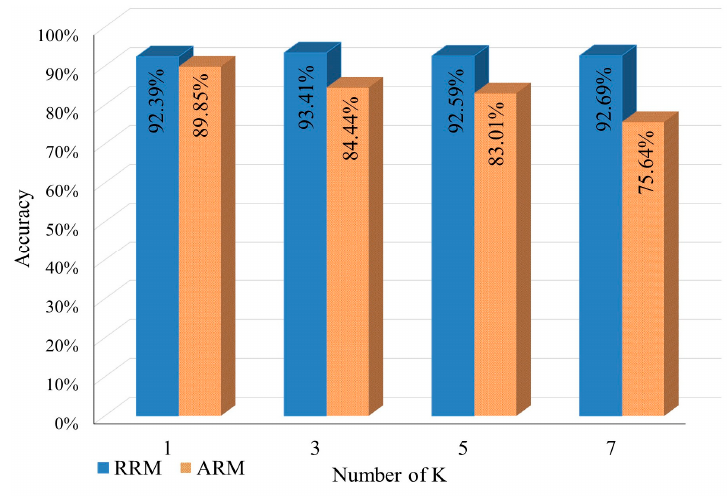
Figure 7. The accuracy of IPS when using ANN in each room.